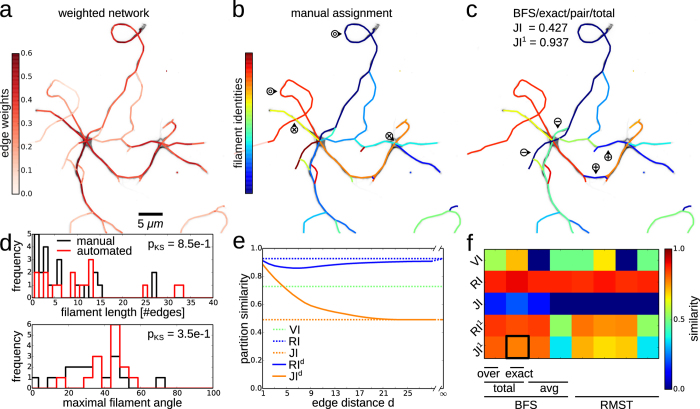
Filament covers and analyses of neuronal network.The weighted hippocampal neuronal network is automatically decomposed into filaments by solving the exact FCP (exact) for paths from a modified breadth-first search (BFS) and by minimising the total (total) pairwise filament roughness (pair). (a) Overlay of fluorescence microscopy image of hippocampal neurons and extracted network with colour-coded edge weights. (b) Manual decomposition of the neuronal network into filaments with colour-coded indices and crossings (⊗) and loops (). (c) Automated partitioning of the network obtained by solving the FCP displays good agreement with the manually obtained partitioning (JI1 close to 1, see panel (e) for details) with marked illustrative sites of over- () and under-segmentation (). (d) Distributions of numbers of edges per filament (upper panel) as well as distributions of maximum filament angles (lower panel) are similar for manual (black) and automated decomposition (red; Kolmogorov-Smirnov test pKS ≥ 0.05). (e) Different measures of similarity of manual and automated decompositions. The variation of information VI (dashed green) indicates moderate similarity but is not well-defined for general, overlapping decompositions. While the classical Jaccard index JI (dashed yellow) is of small value, the proposed structure-aware extension JId increases with decreasing d, i.e., when only edges are considered that are separated by at most d nodes (solid yellow). Moreover, while the classical Rand index RI (dashed blue) is of large value, the proposed structure-aware extension RId displays a non-monotonic dependence on d (solid blue). (f) Heat map of partition similarities for different similarity measures and options of the FCP, cf. Fig. 1 for a demonstration of the different options. The FCP options which yield the partition shown in (c) are marked by a black rectangle.